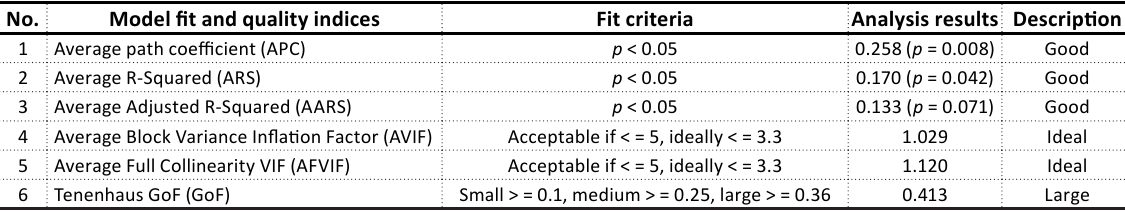
Table 2. Test results of model fit